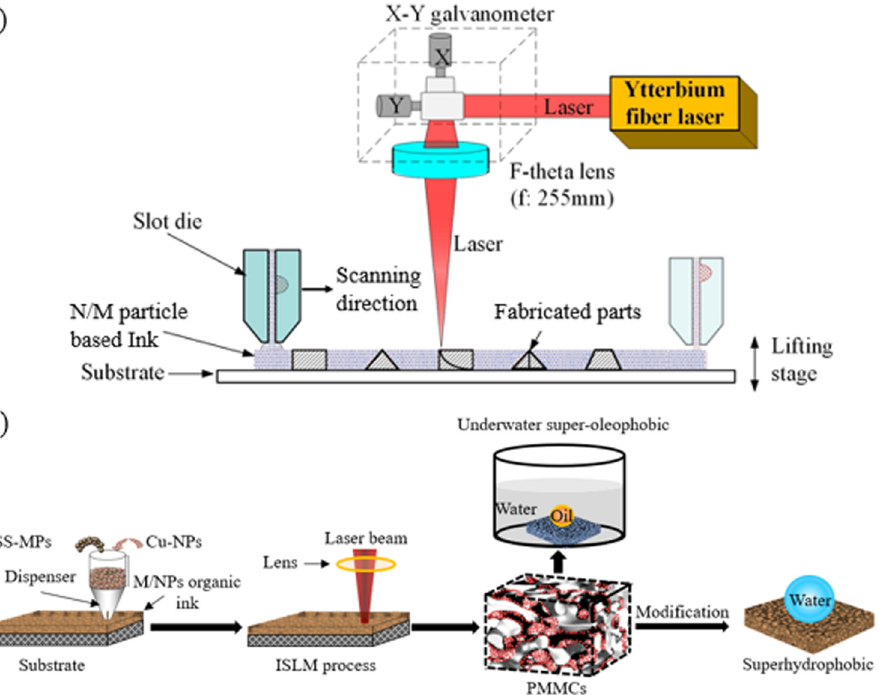
Figure 1: ( a ) Schematic of the ISLM framework of hierarchical metal composites consisting of ink deposition, laser scanning, as - built oleophobicity, and surface modi fi ed super - hydrophobicity and super - oleophilicity; ( b ) schematic of the ISLM process consisting of a single moving laser beam, an organic solvent with micro/nanoparticles, built parts and a